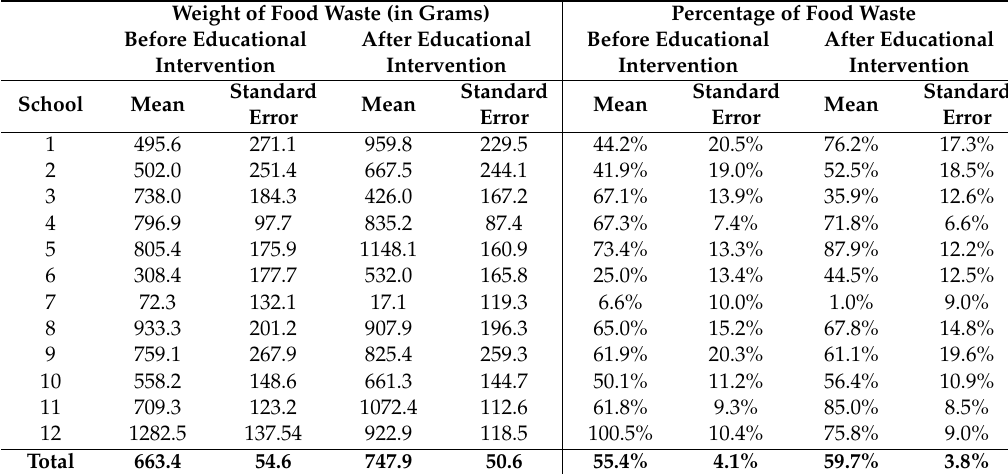
Table 3. Weights and percentages of students’ side dish waste before and after educational intervention. No statistically significant di ff erences were found between the 2 time points or between schools. Weight of Food Waste (in Grams) Percentage of Food Waste Before Educational After